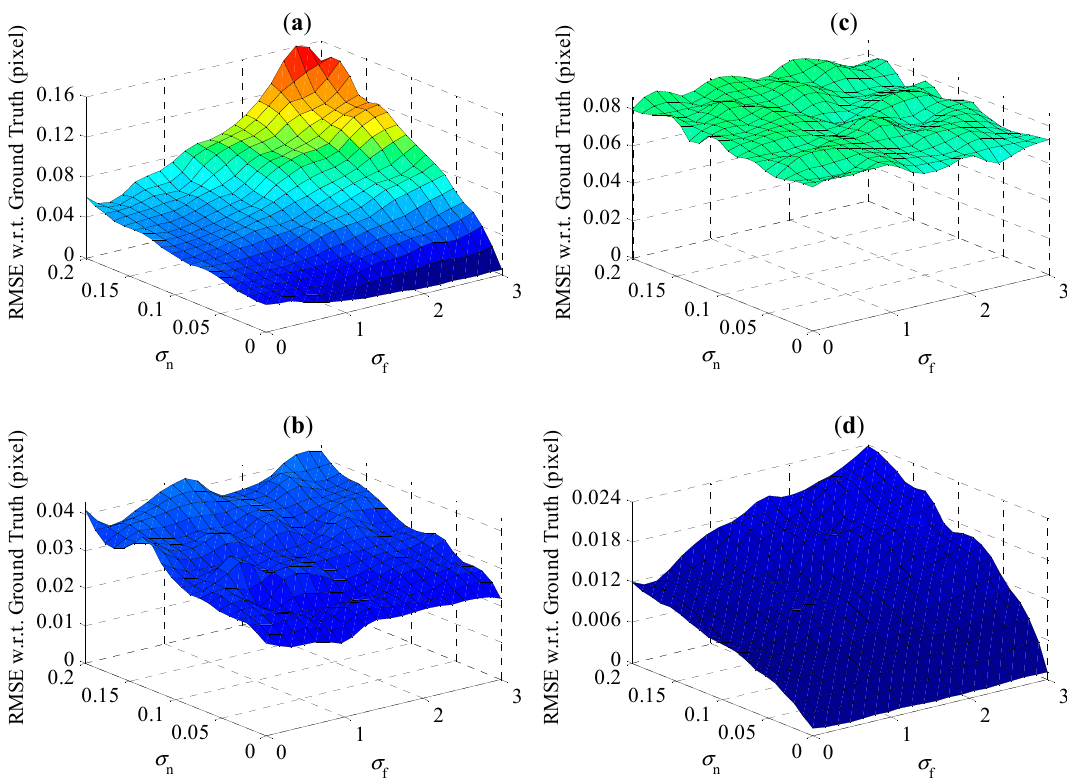
Figure 6. Localization error with respect to blur strength σ f and noise level σ n for ( a ) [16], ( b ) [20], ( c ) [24], and ( d ) the proposed technique.